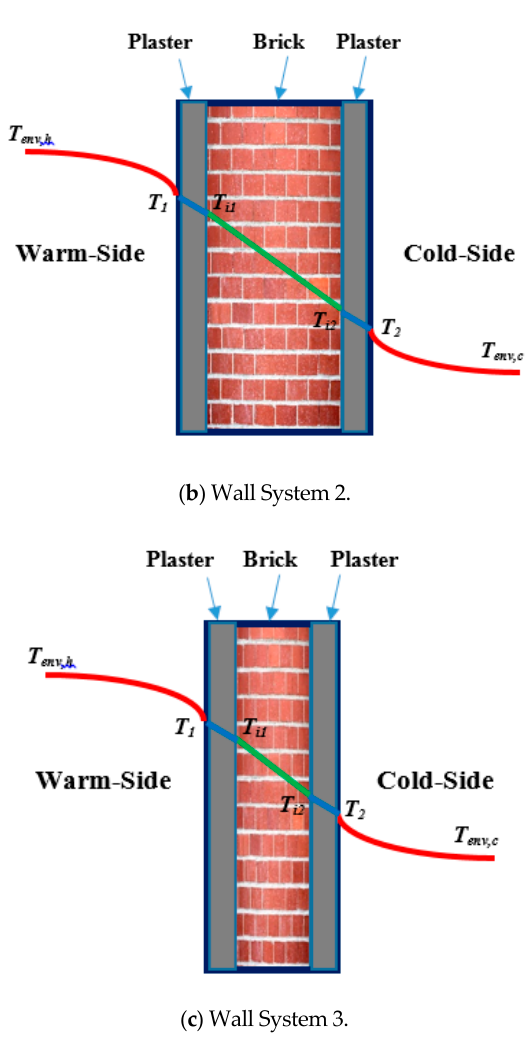
Figure 3. Typical wall systems used in Egypt residential construction: ( a ) Wall System 1, ( b ) Wall System 2, and ( c ) Wall System 3.